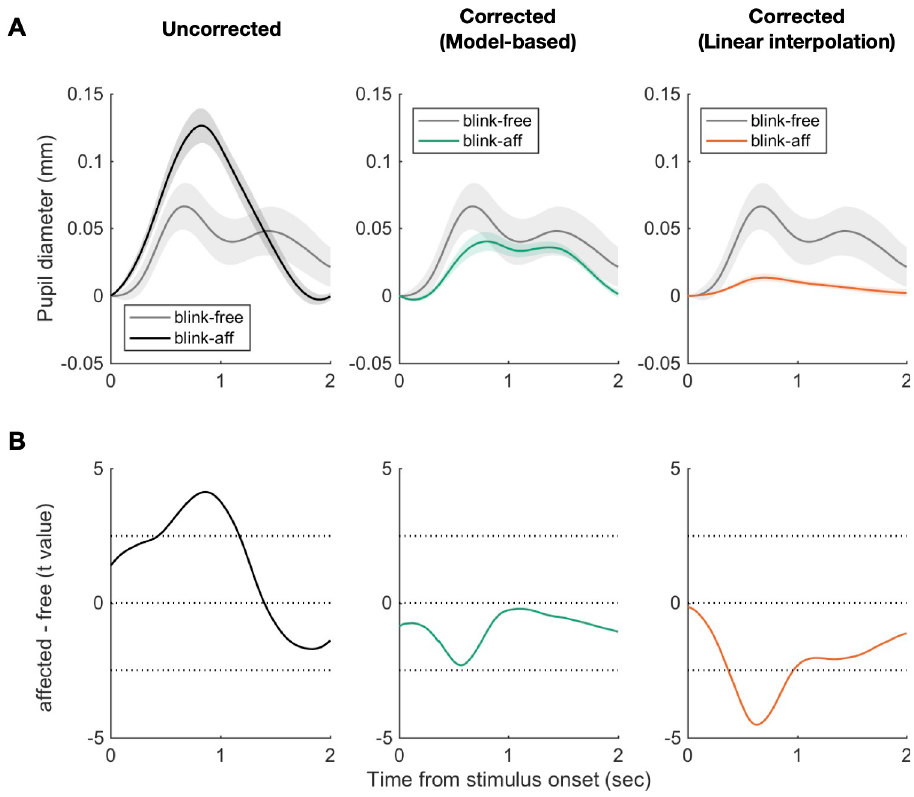
Fig 6. Comparison of the blink-affected trials and the blink-free trials before and after correction. ( A ) The time courses of pupil size before (left) and after correction (middle and right). The gray lines represent the mean time course of pupil-size measurements in the blink-free trials. The black line is the mean time course of pupil size in the blink-affected trials before correction. The green and orange lines represent the mean time courses of pupil size after correction with the model-based method and the linear interpolation method. Shades represent standard errors of the mean (SEM) across subjects. ( B ) The time courses of t statistics (“blink-affected”–“blink-free,” df = 23) of the difference between the blink-affected and the blink-free trials. Horizontal dashed lines indicate the values of t statistics where the significance level is 0.01, and t = 0.